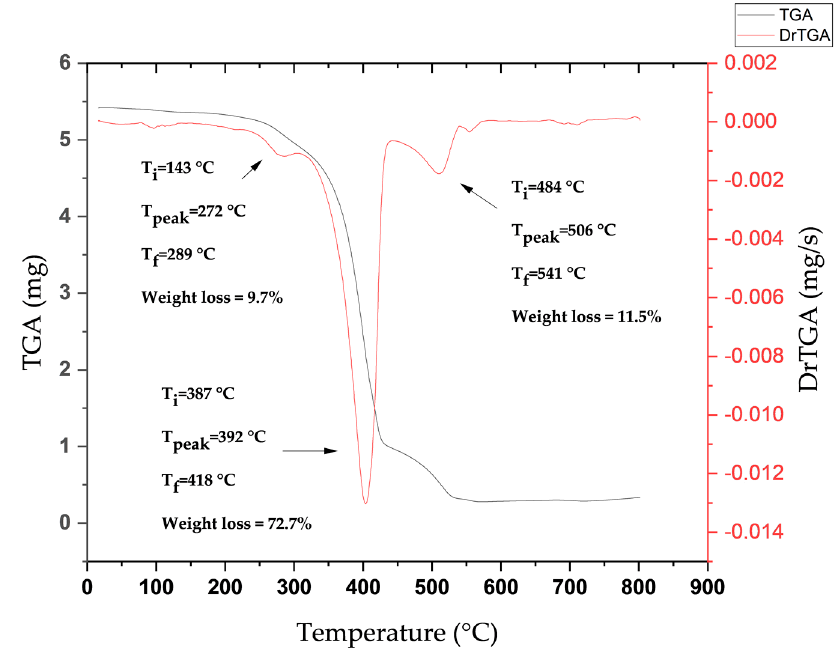
Figure 12. TG analysis of WEEE plastic feedstock.